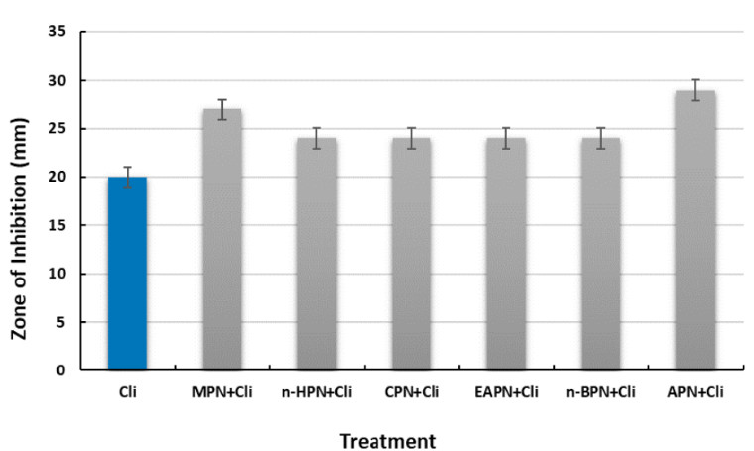
Figure 3. Antibiotic reversal activity of P. nigrum extracts in combination with erythromycin ( 15 μg) for S. aureus.